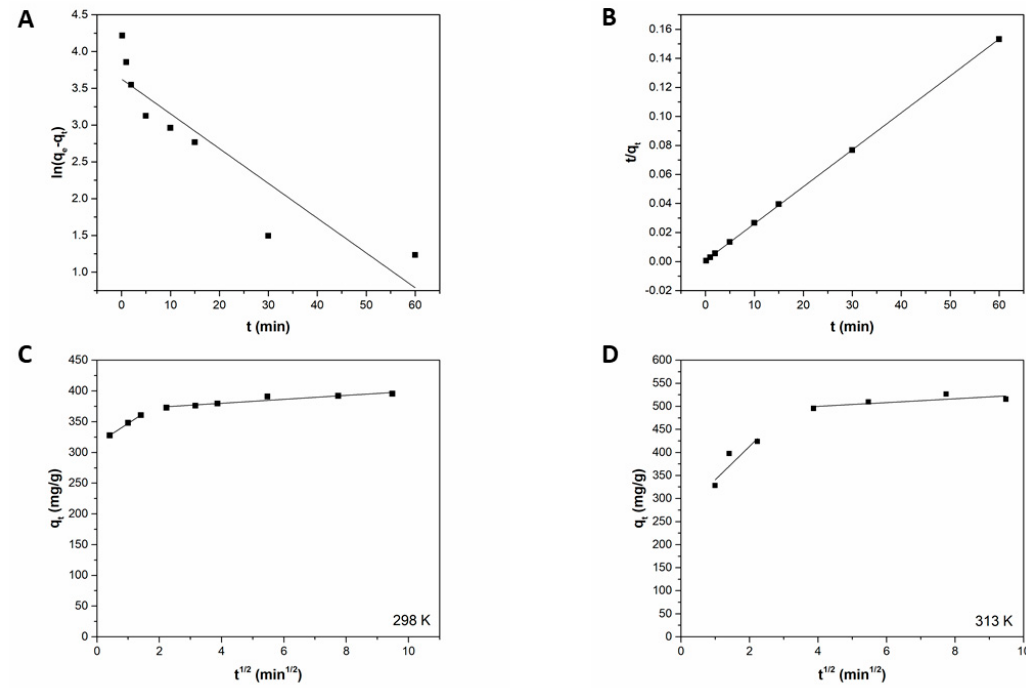
Figure 6. ( A ) Pseudo-first order, ( B ) pseudo-second order, and ( C , D ) intraparticle diffusion model at 298 K and 313 K, respectively, for MB adsorption onto Liposome@PDA microspheres. Table 2. Kinetic parameters of the models shown in Figure 6.